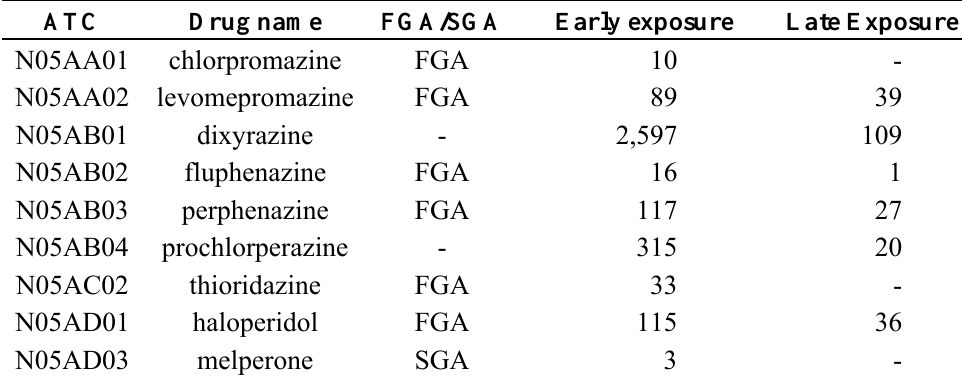
Table 18. Number of infants exposed in early pregnancy for neuroleptics or born by women who had filled prescriptions for neuroleptics during the 2nd or 3rd